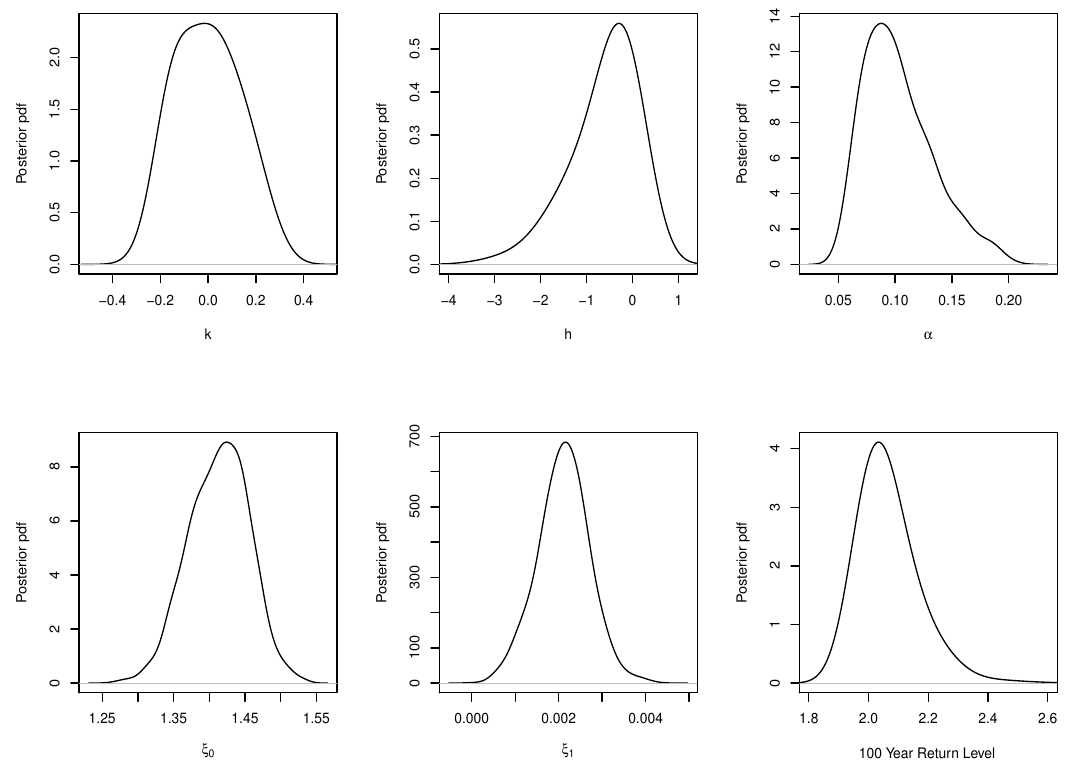
Figure 13. Posterior probability density function for each of five parameters ( k , h , α , ξ 0 , and ξ 1 ) and the 100-year return level (lower rightest figure) obtained by the Bayesian method with the prior P1 given in the Section 4.2 using the non-stationary four-parameter kappa distribution, for the annual maximum sea-levels (unit: m) recorded at Fremantle, Western Australia,